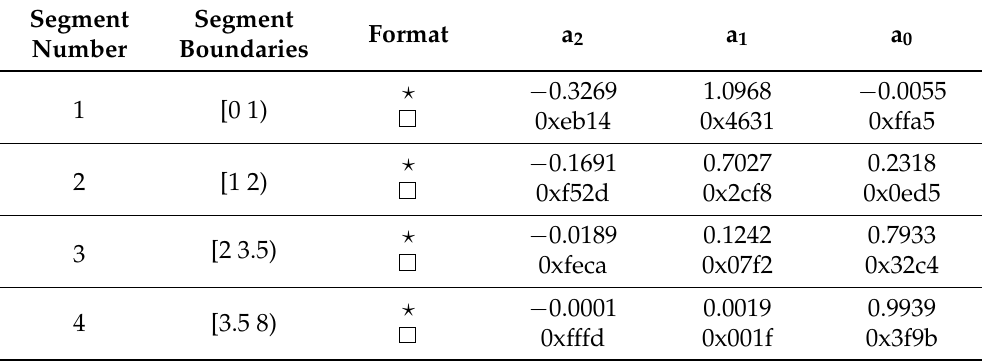
Table 4. Floating-point and fixed-point coefficients for implementing Tanh AF in